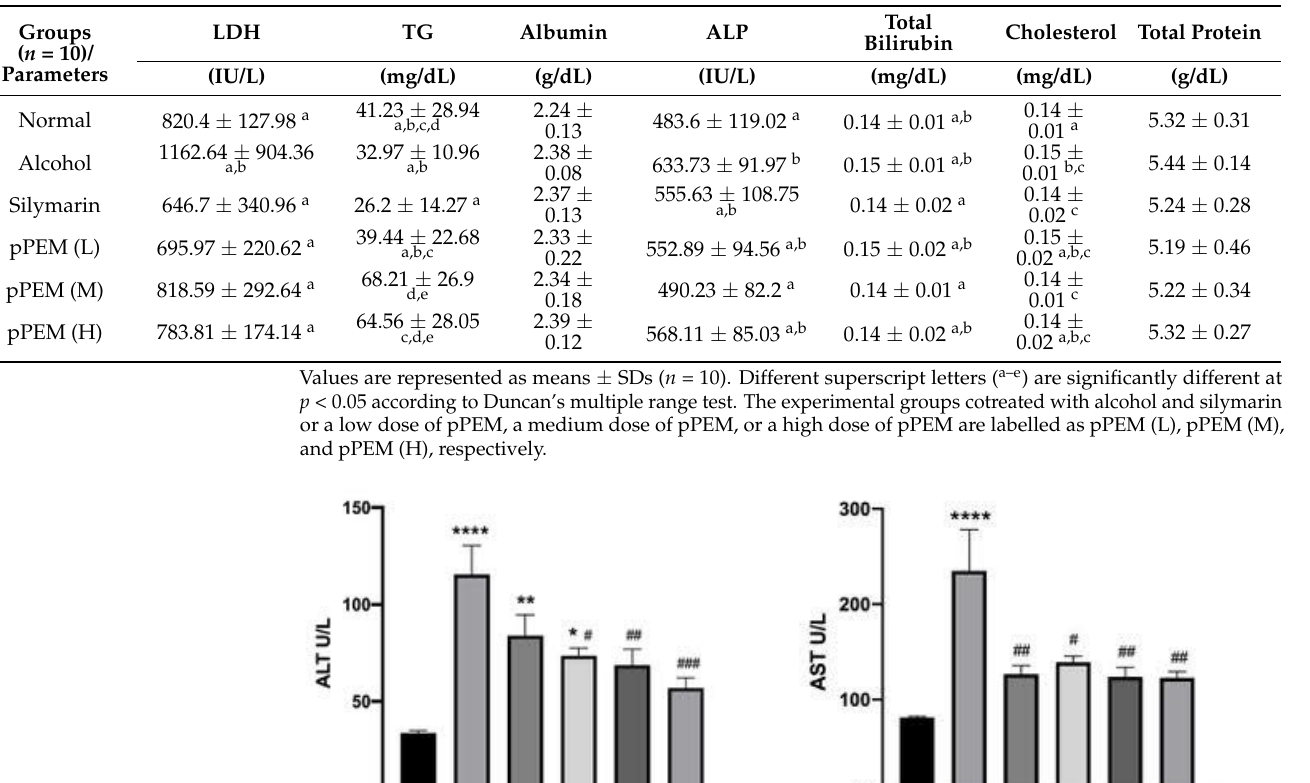
Table 2. Effects of pPEM on several serum biochemistry values in alcohol-treated rats.